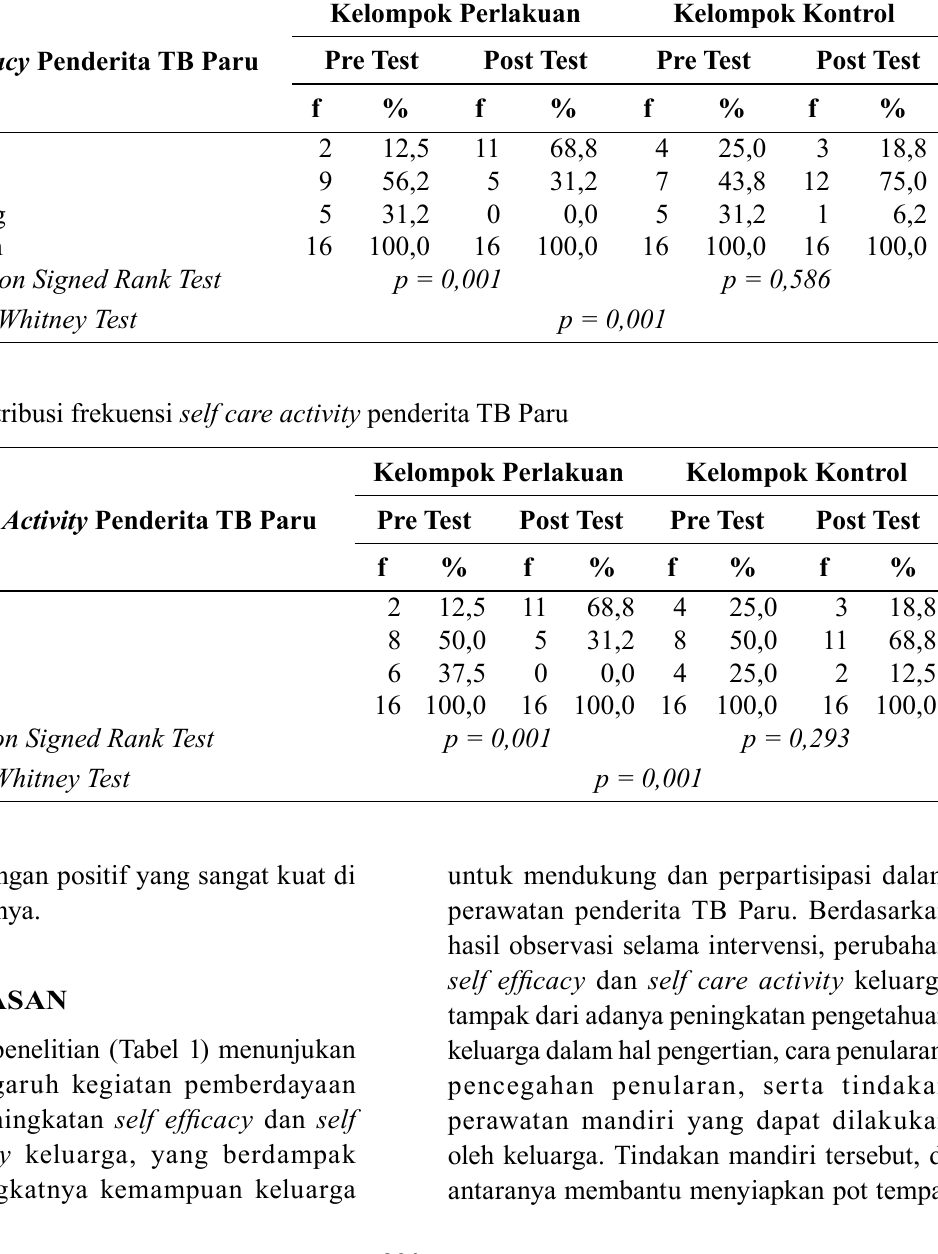
Tabel 3. Distribusi frekuensi self ef fi cacy penderita TB Paru